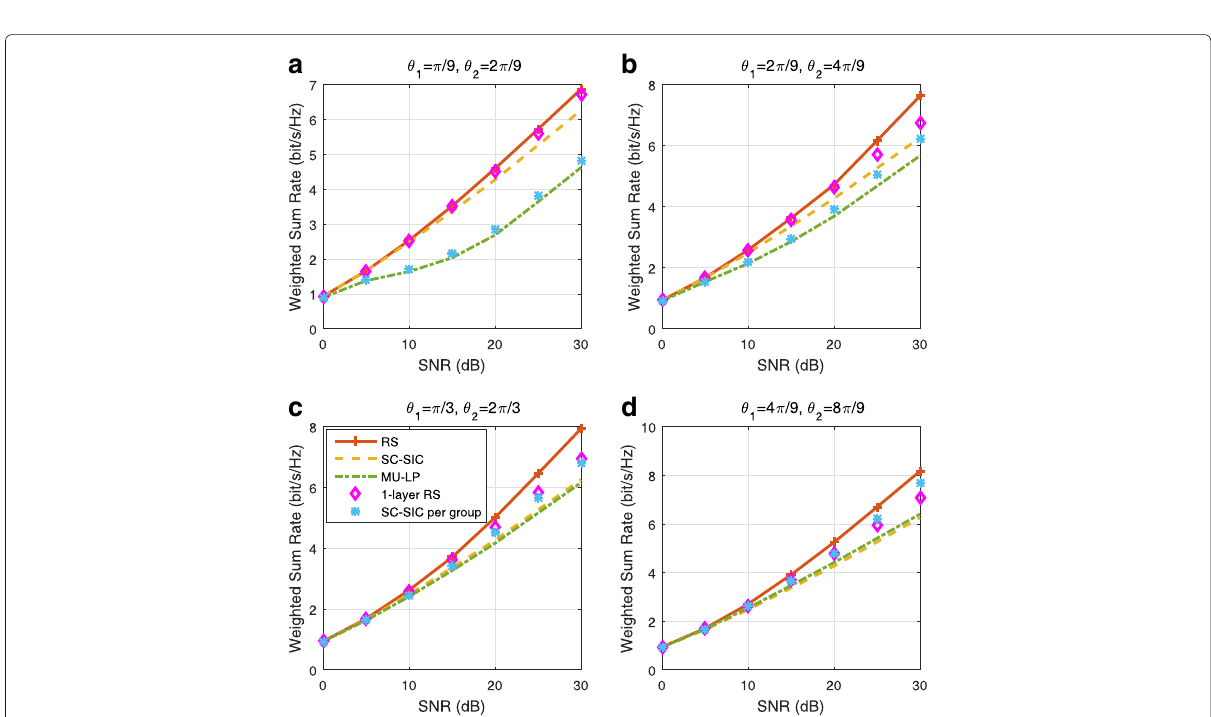
Fig.41 WeightedsumrateversusSNRcomparisonofdifferent strategies for overloaded three-user deployment with perfect CSIT, γ 1 = γ 2 = 1, u 1 = 0.6, u 2 = 0.3, u 3 = 0.1, N t = 2, r th = [0.02,0.08,0.19,0.3,0.4,0.4,0.4] bit/s/Hz. a θ 1 = π/ 9, θ 2 = 2 π/ 9. b θ 1 = 2 π/ 9, θ 2 = 4 π/ 9. c θ 1 = π/ 3, θ 2 = 2 π/